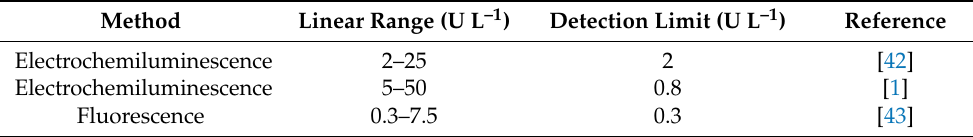
Table 1. Comparison of the present method with other methods for ALP